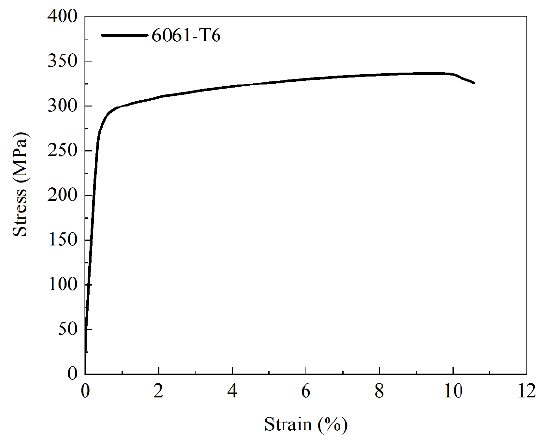
Figure 8. Stress-strain curve of the aluminum alloy. Table 3. Material properties of aluminum alloy 6061-T6.